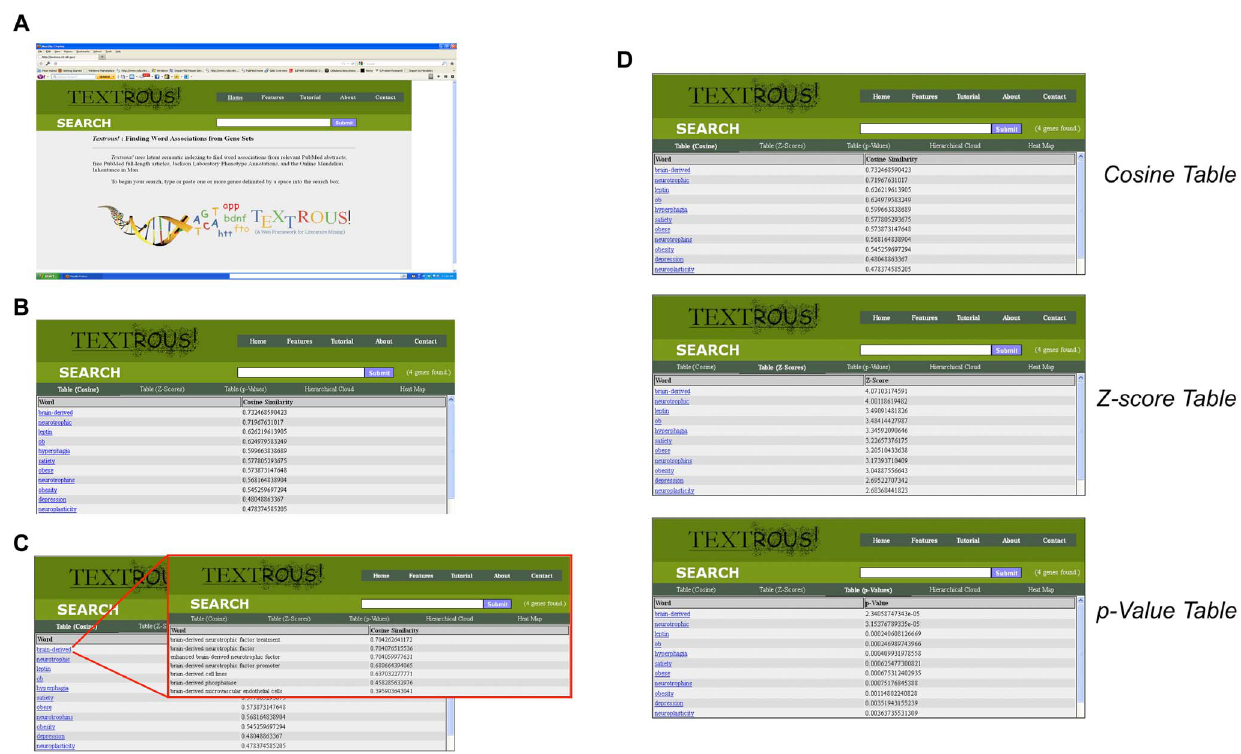
Figure 2. Web-based user interface for Textrous! . (A) The main navigation bar is on the top-right. The search bar is below the main navigation bar, and the secondary navigation bar is below the search bar. Features can be accessed by clicking the appropriate menu item, phrases by clicking on the word hyperlinks, and excluded words by clicking the ‘‘(x genes found)’’ description in the search bar. (B) Primary Cosine Similarity output from Textrous! user interface. The main navigation bar is on the top-right. The search bar is below the main navigation bar, and the secondary navigation bar is below the search bar. The ‘Cosine Similarity’ output is demonstrated for the following Gene Symbol input sequence: Lep, Bdnf, Fto, Lepr. After symbol input into the ‘Search’ box then the cosine similarity word list is generated by pressing ‘Submit’. Automatically the ‘Cosine Table’ is depicted first. Additional textual output modes can be accessed subsequently using the toolbar. (C) Phrase hyperlinking from Cosine Similarity tables. Each word term generated from the input query list can be clicked on to link out (in red box) to the phrases in which it resides. The phrases containing the identified word are ranked according to their cosine similarity as well. (D) In addition to the Cosine Similarity output feature, the resulting word lists can be assessed by their output Z-score table or the probability scores in their p-value table. In each of these text word output formats each word can be linked out to its phrase context scoring box as in Figure 5.